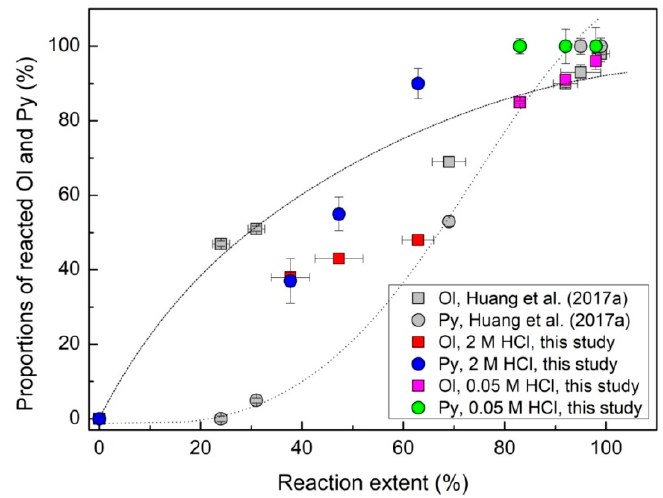
Figure 5. The proportions of serpentinized olivine and pyroxene minerals (%) as a function of reaction extent (%). Gray symbols are data from Huang et al. [23], and colored symbols are experimental data of the present study.